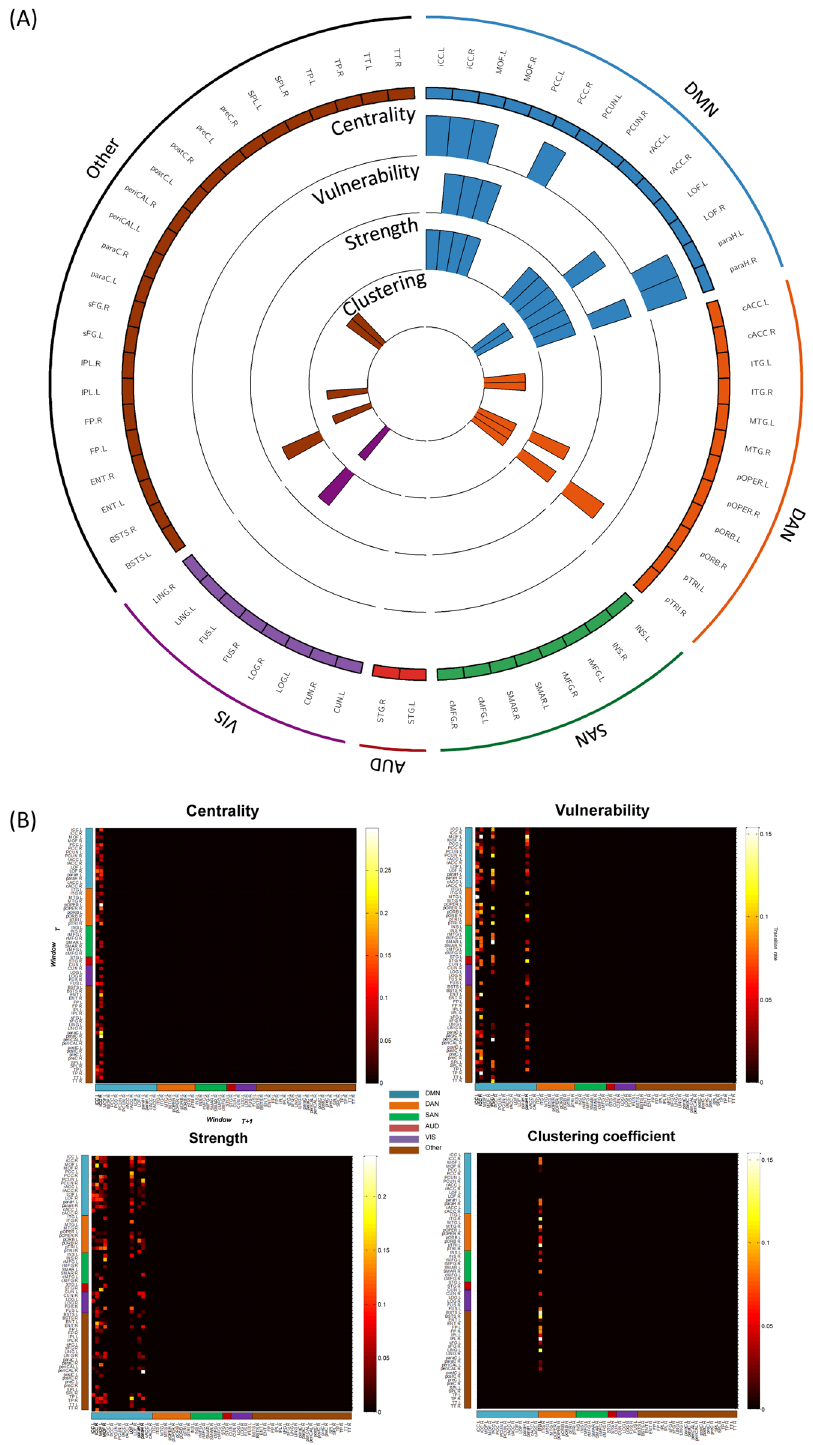
Figure 4. Dynamic analysis: graph metrics. ( A ) The distribution of the four measures across the 68 brain regions. The four circular barplots reflect (from the outside inward): centrality, vulnerability, strength and clustering coefficient. The outermost ring shows the 68 brain regions (obtained from the anatomical parcellation based on Desikan-Killiany atlas 61 ), arranged by their assigned resting state networks: default mode network (DMN), dorsal attentional network (DAN), salience network (SAN), auditory network (AUD), visual network (VIS) (see Table S1 in Supplementary Materials). We only retain the bars for significant nodes ( p < 0.01, Bonferroni corrected). ( B ) The temporal transitions between the 68 brain regions in terms of centrality, strength, vulnerability and clustering coefficient. Only significant columns are shown ( p < 0.01, Bonferroni corrected). Names and abbreviations of the brain regions are listed in Table